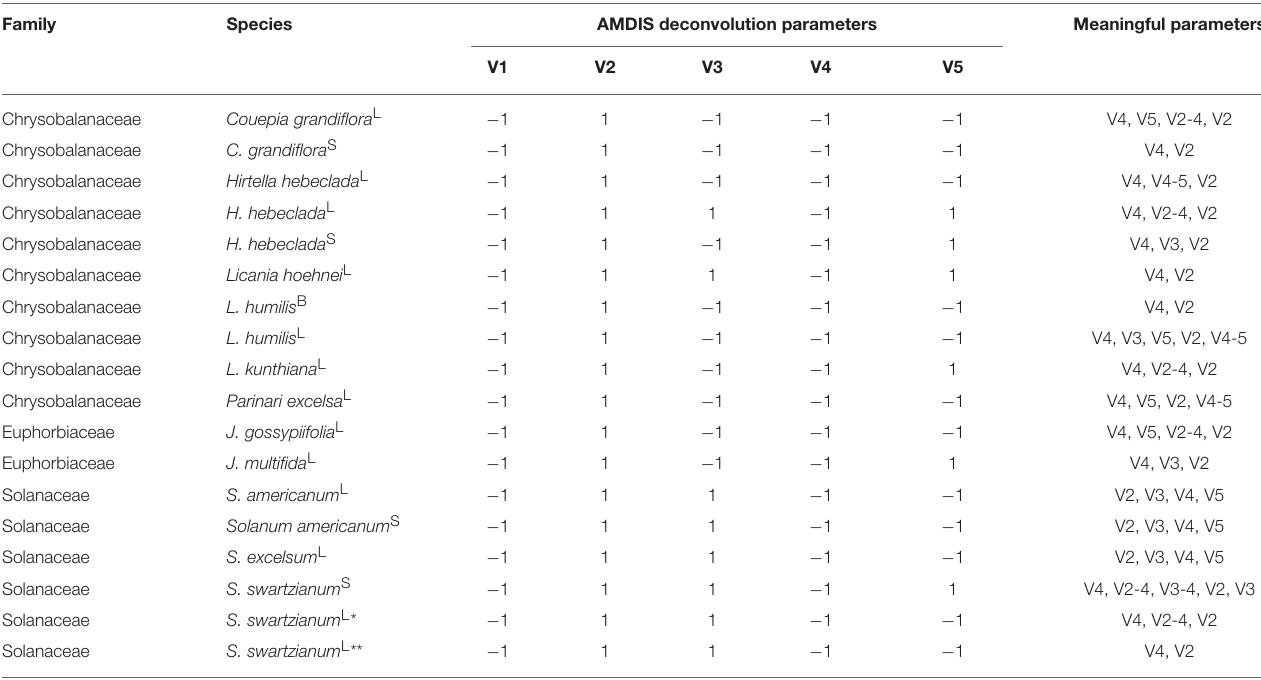
TABLE 2 | Optimized AMDIS deconvolution and identification parameters using CDF. Family